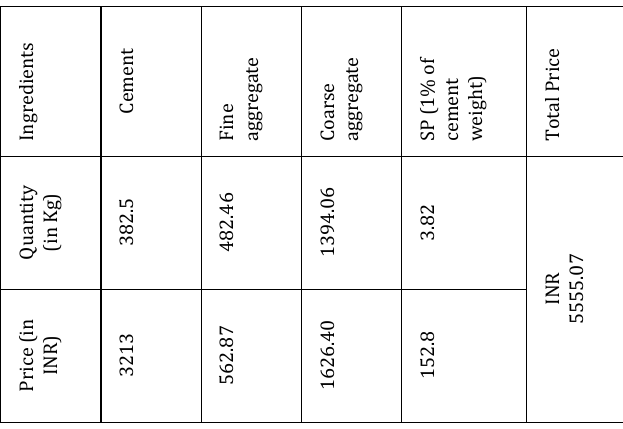
Table 9: (price details of M-40 mix for 1m 3 concrete without RHA)